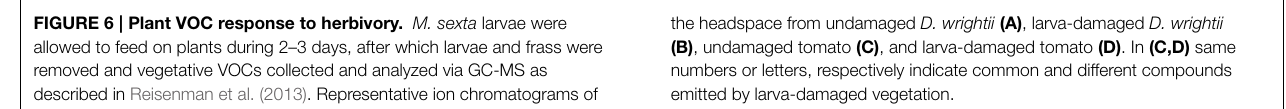
that the AL discriminates between larva-damaged and intact plants ( Figure 8E ). Knowledge of the compounds that are discriminated at this level of olfactory processing readily informs about the suite of VOCs that could potentially mediate the behavioral selection of appropriate host